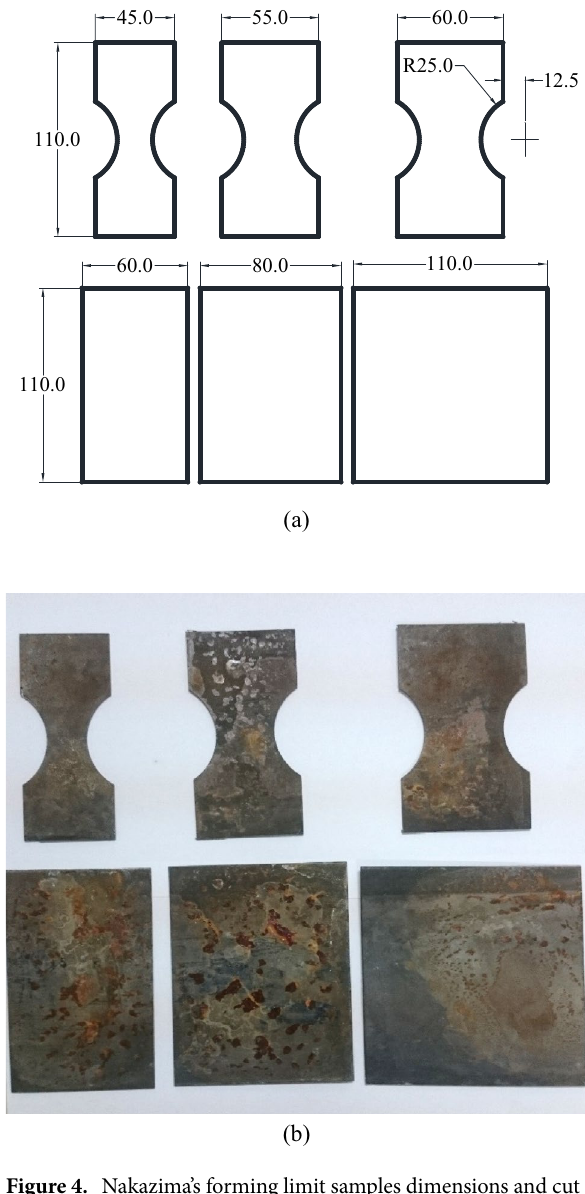
Figure 4. Nakazima’s forming limit samples dimensions and cut sheets. The oxide scale on the sheets were due to oxygen containing atomosphere of the furnace which was later grounded before conducting Nakazima